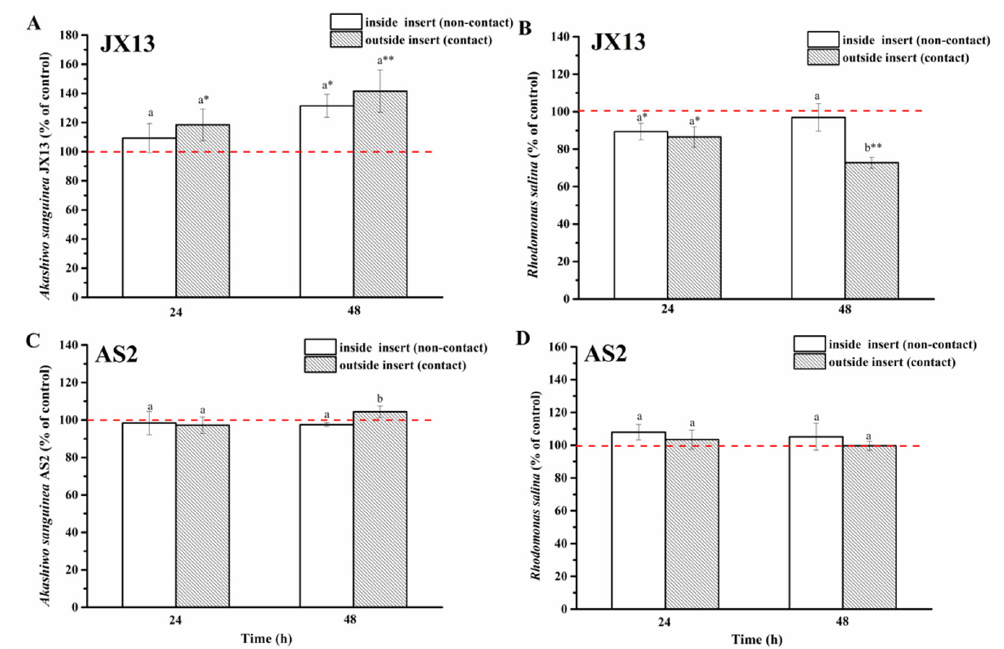
Figure 6. Half-contact coculture of Akashiwo sanguinea (JX13, AS2) and Rhodomonas salina CCMP1319. ( A , B ): A. sanguinea JX13 co-cultured with R. salina ; ( C , D ): A. sanguinea AS2 co-cultured with R. salina . Initial cell densities of A. sanguinea and R. salina were 3000 cells mL − 1 and 1000 cells mL − 1 , respec- tively. Results are expressed in triplicate ± standard deviation (SD). Different lower-case letters (a, b) indicate significant differences ( p < 0.05) between treatments at the same co-culture times; * and ** indicate significant differences ( p < 0.05 and p < 0.01, respectively) between treatment and control.